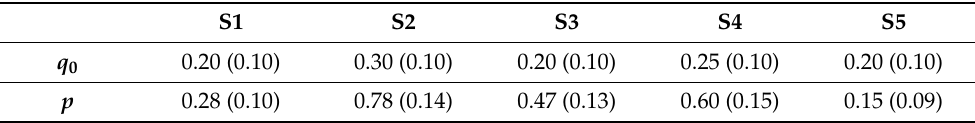
Figure 7. Free volume fraction in the investigated elastomers, evaluated using the spherical approximation (circles) and the anisotropic cylindrical model (squares). The continuous line represents the theoretical free volume fraction h . Table 3. Best fit values of parameters q 0 and p for the investigated elastomers. Uncertainties are shown in parenthesis.